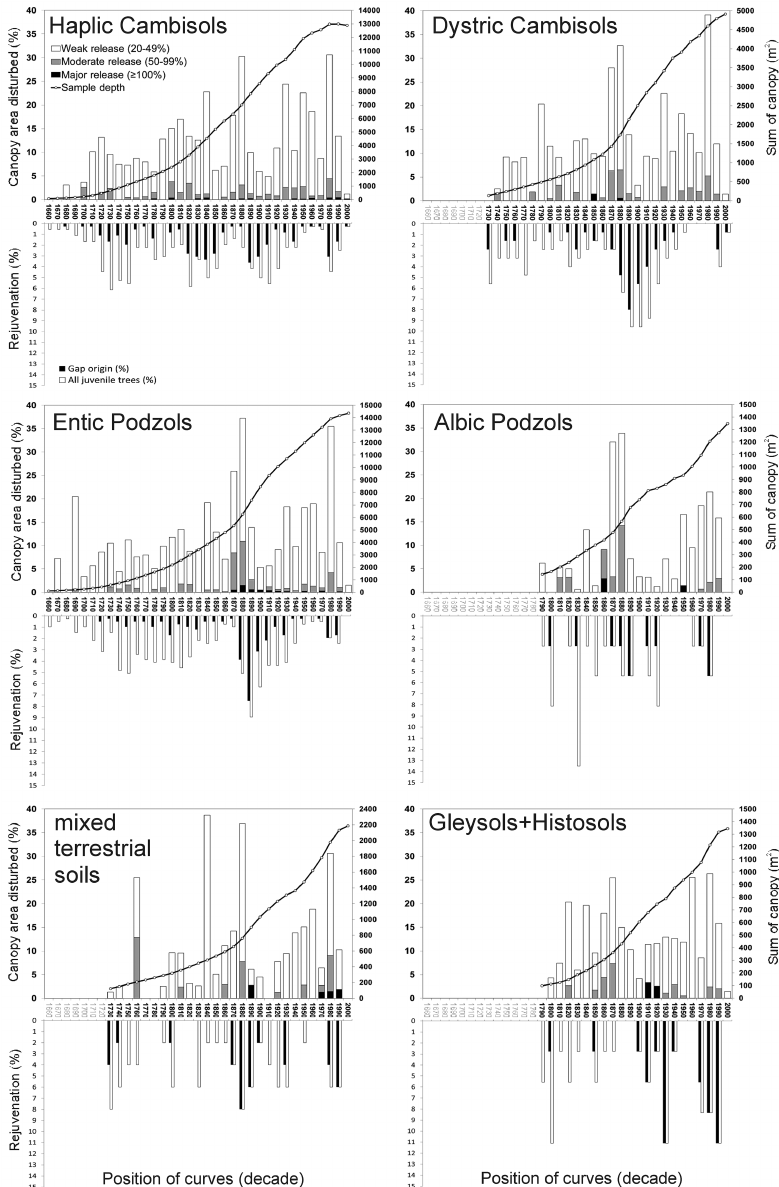
Figure 4. Disturbance history of the Žofín core zone based on dendrochronological data in relation to the predominant soil taxonomical units (Fig. 2). Columns represent the number of juvenile trees (lower part of the figure) and the canopy area disturbances (upper part of the figure; the height of white, grey and black bars indicate the canopy area disturbed separately for weak, moderate and major release events in radial growth). Sum of canopy is the relevant area of all exposed crowns in the dendrochronological record, i.e. sample depth in individual decades. This variable is dependent on the number of cored trees within soil unit and relation between DBH and crown area (Table 1, Šamonil et al., 2013a). The canopy areas were estimated for every year a cored tree was in the record, crown areas gradually decreased to the past. Chronologies were truncated when the sample depth (refers to the second y -axis) dropped below 15 trees (for details, see Sect.